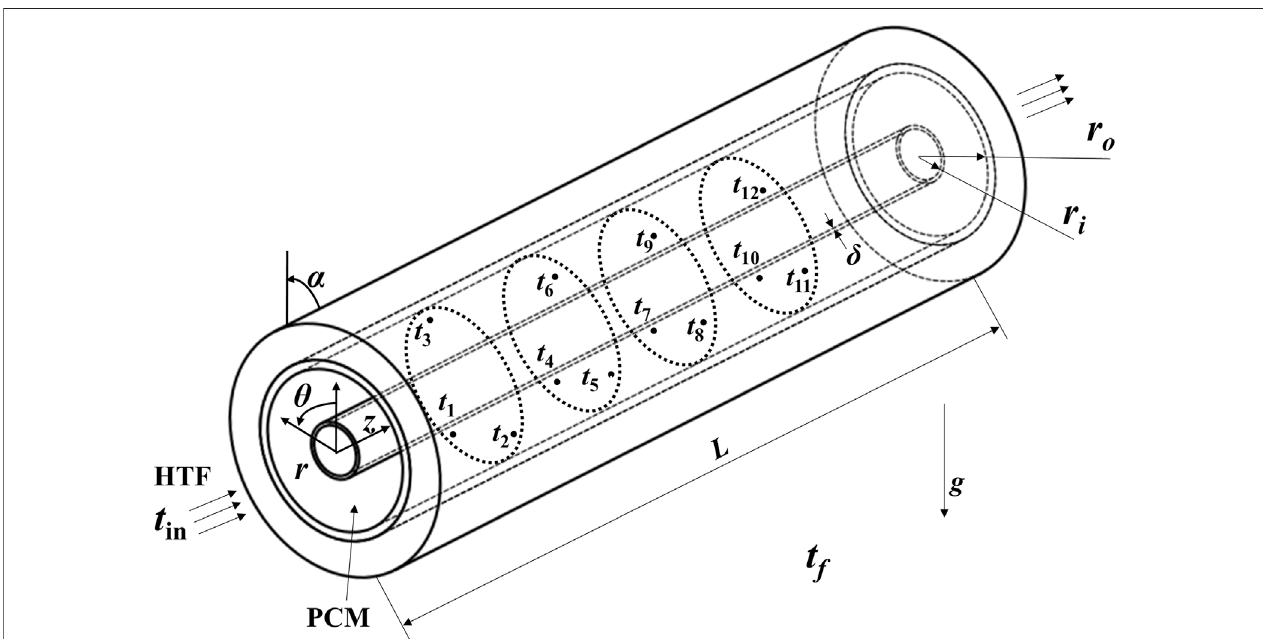
FIGURE 2 | Schematic diagram of the experimental